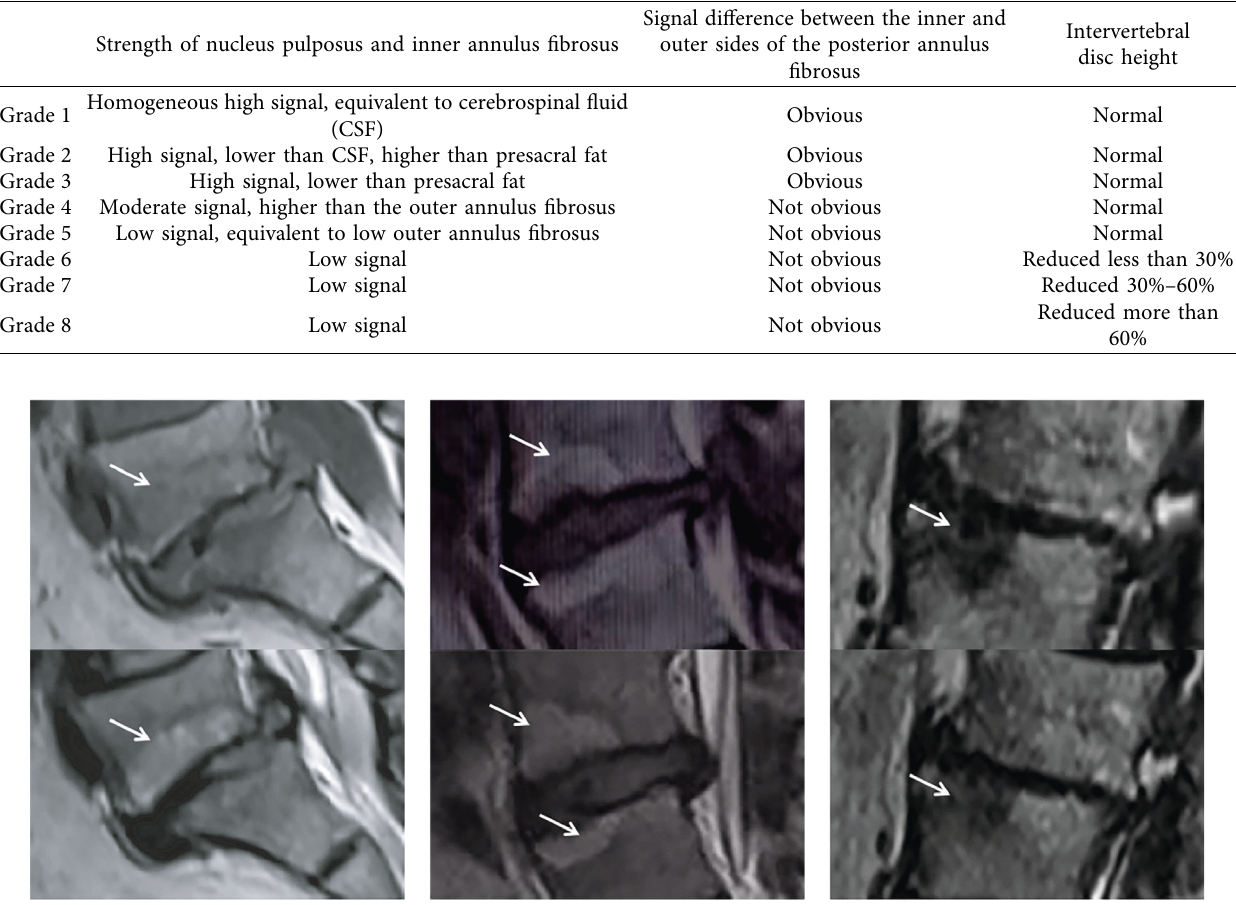
Table 1: Modified Pfirrmann grading system.